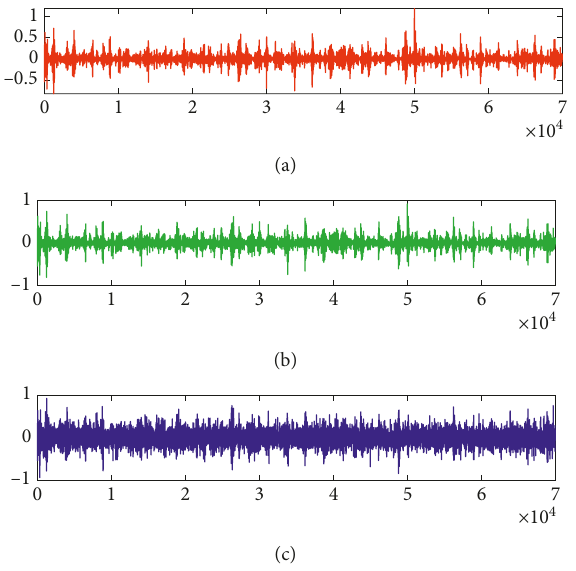
Figure 14: The error signal e (c) α 0.01. (cid:29)